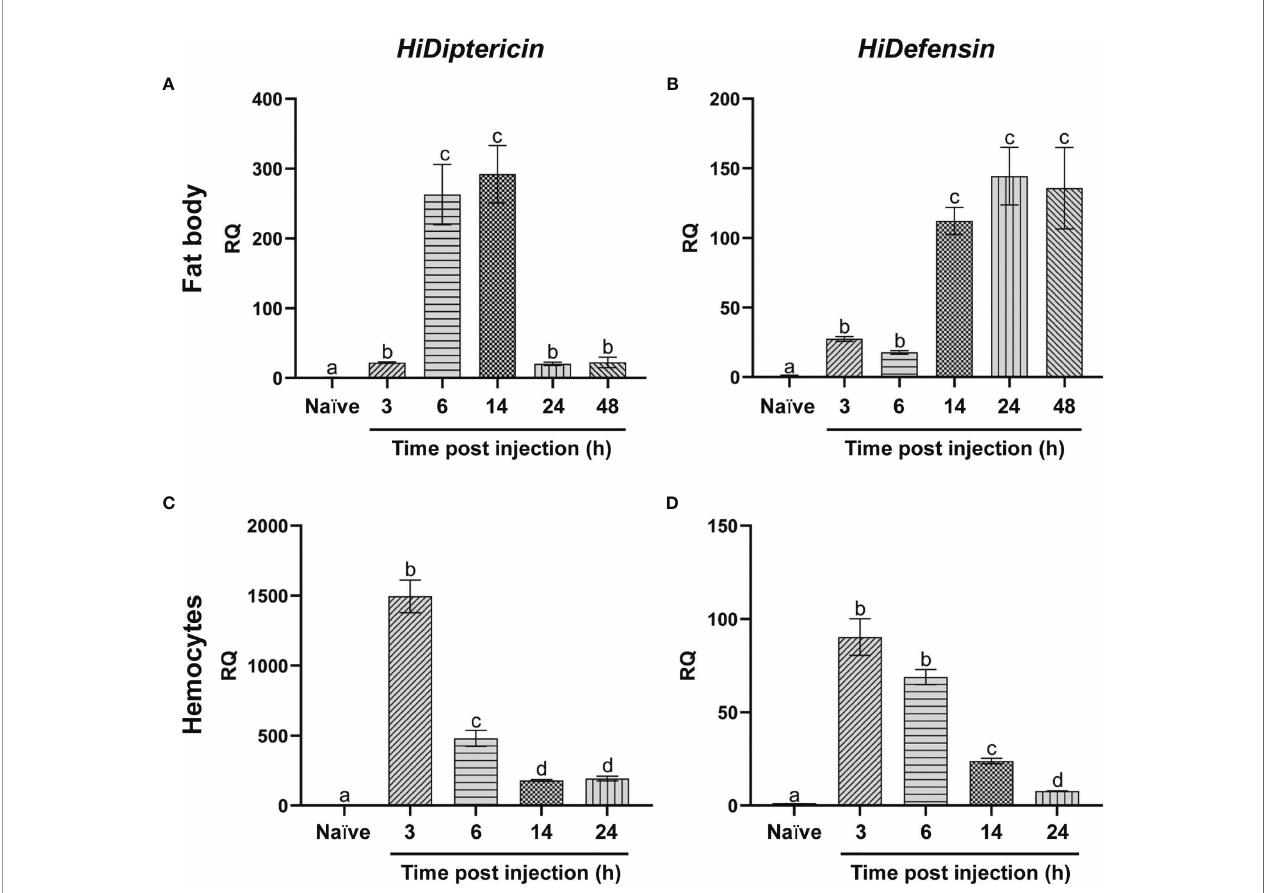
FIGURE 7 | qRT-PCR analysis of antimicrobial peptides. (A, C) mRNA levels of HiDiptericin in the fat body (A) and hemocytes (C) of naïve and infected larvae at different time points; (B, D) mRNA levels of HiDefensin in the fat body (B) and hemocytes (D) of naïve and infected larvae at different time points. Naïve larvae starved for 3 hours were used as controls. Values represent mean ± s.e.m. Different letters indicate statistically signi fi cant differences among treatments (One-Way ANOVA: A ) F 5-12 = 178.8, p < 0.0001; B ) F 5-12 = 127, p < 0.0001; C ) F 4-10 = 532.6, p < 0.0001; D ) F 4-10 = 658.3, p <